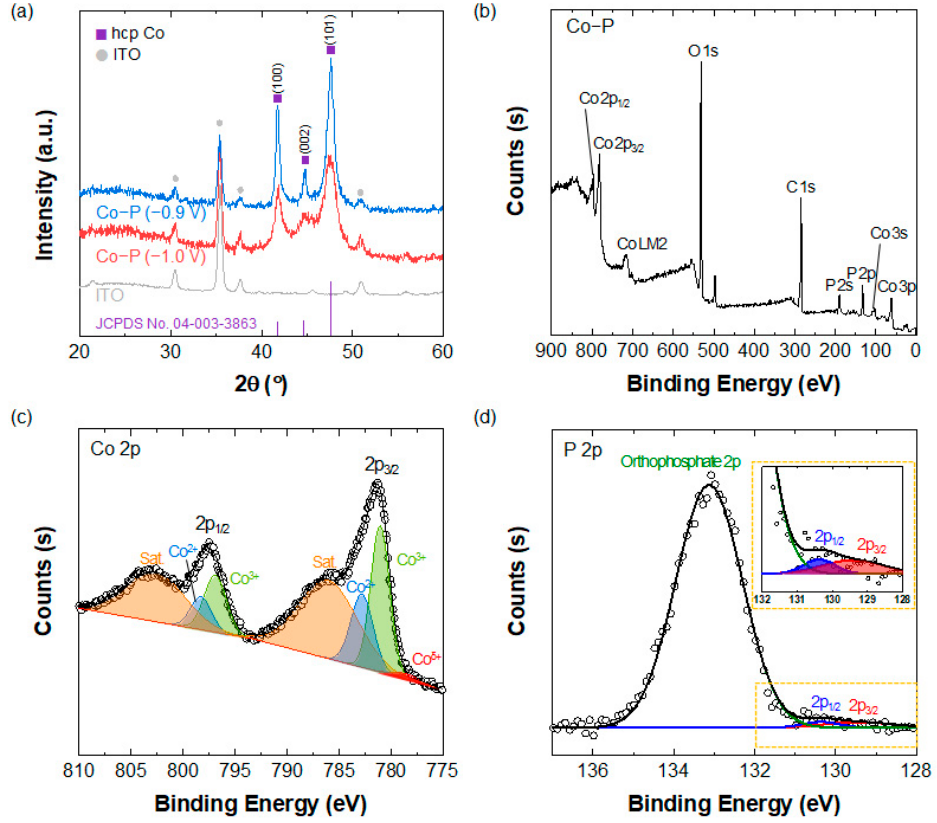
Figure 2. ( a ) XRD patterns of Co − P electrodeposited at applied voltages of − 0.9 and − 1.0 V on ITO substrate. ( b – d ) XPS spectra of Co − P prepared at − 1.0 V. ( b ) Survey scan and high-resolution spectra of ( c ) Co 2p and ( d ) P 2p of the Co − P nanoclusters.